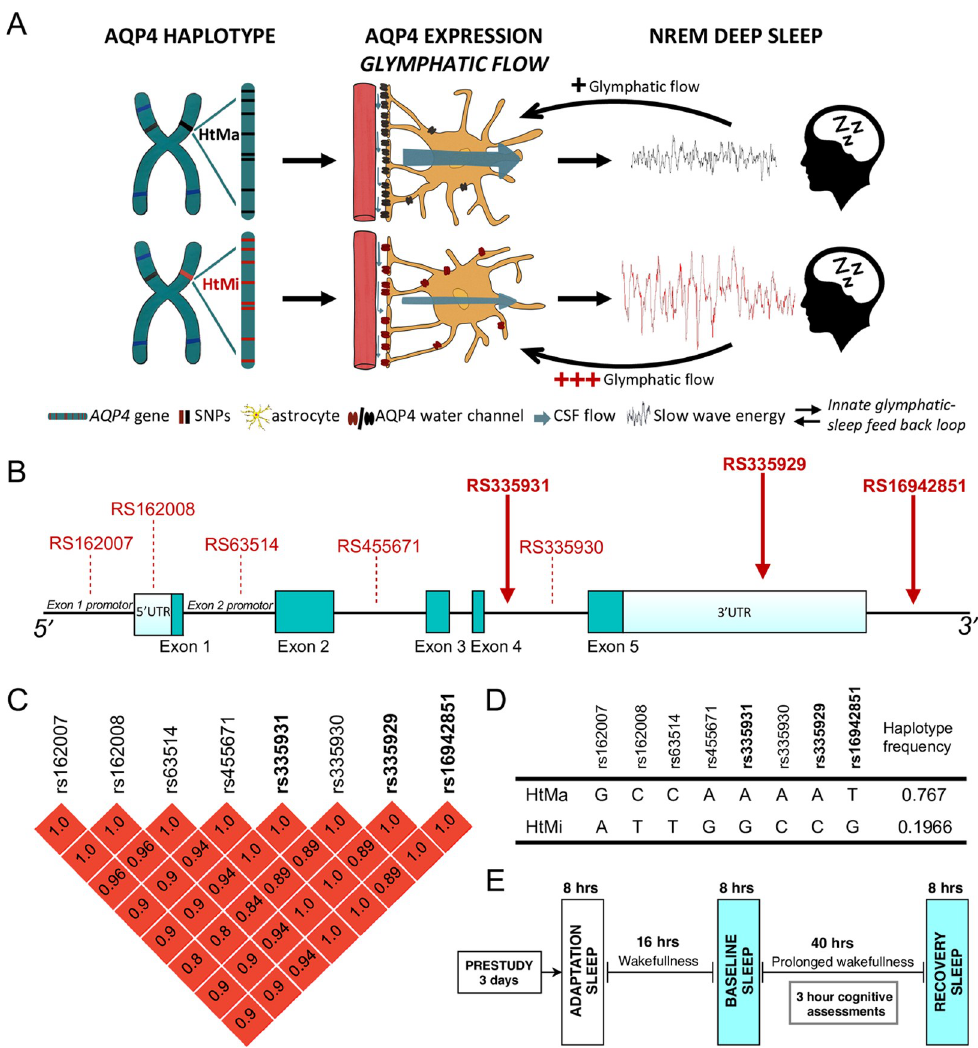
Fig 1. Hypothesized role of the human AQP4 -haplotype investigated in a controlled sleep deprivation study. (A) Based on the genetic modulation of AQP4 protein expression [22], we hypothesized that the high AQP4 expressing variant of the AQP4 -haplotype (HtMa; black) presents with improved glymphatic flow compared to the low AQP4 expressing HtMi variant (red). Assuming that NREM slow waves are the endogenous regulator of glymphatic flow, the HtMa variant require less SWE to initiate glymphatic flow than the HtMi variant, establishing an innate glymphatic-sleep feedback loop. (B) Physical map of the AQP4 gene and the location of the 8 haplotype SNPs. The 3 SNPs genotyped in this sample are marked with full red arrows. Dark green blocks: coding exons; light blue blocks: 5 0 - and 3 0 -untranslated regions. (C) LD block among the AQP4 SNPs in the investigated haplotype. The pairwise LD coefficients (r 2 ) of SNPs in the LD block are color-scaled in red tones with dark red indicating perfect LD (r 2 = 1). (D) Table shows bases at the 8 different SNP locations in the AQP4 gene for the 2 haplotypes HtMa (76.7%) and HtMi (19.7%) and their respective frequencies in the CEU and TSI populations, representative of the investigated Swiss cohort. A total of 3.7% of CEU and TSI are predicted to be carriers of rare haplotype variants [23]. Frequencies in investigated study population were close to the prediction (HtMa: 75.7%; HtMi: 23.5; others: 0.7%; S1 Data). (E) Visualization of study design common for all subjects included from 6 separate studies. After a minimum 3-day inclusion period with monitored bedtimes and no caffeine intake, all study participants underwent an adaptation night in the laboratory before baseline sleep, 40 hours prolonged wakefulness and a recovery night, adding up to more than 1,950 hours (123 × 2 × 8 hours) of included sleep EEG recordings. Subjective sleepiness ratings and the approximately 10 min PVT were performed at 3-hour intervals. AQP4, aquaporin 4; CEU, Utah Residents from North and West Europe; EEG, electroencephalographic; HtMa, Major allele of haplotype; HtMi, Minor allele of haplotype; LD, linkage disequilibrium; NREM, non–rapid eye movement; PVT, psychomotor vigilance test; SNP, single nucleotide polymorphism; SWE, slow wave energy; TSI, Toscani in Italy;